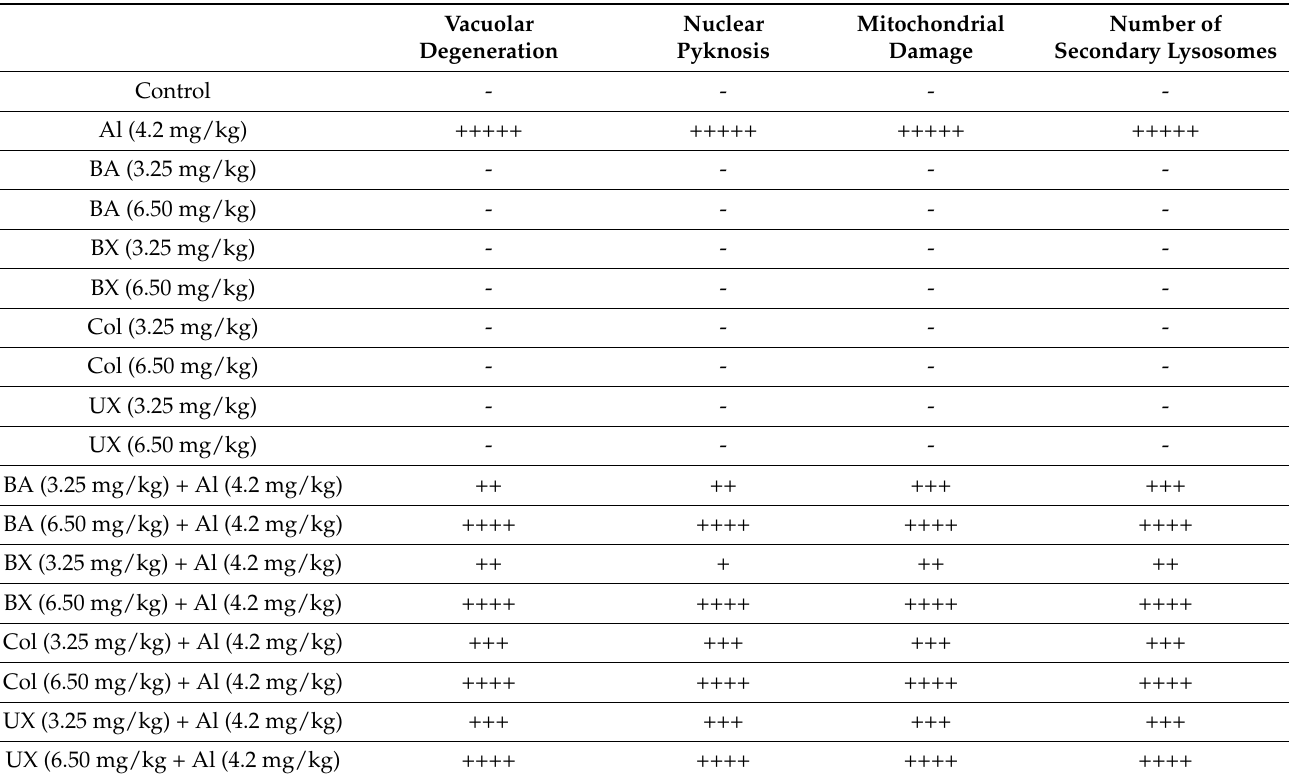
Table 7. Electron microscopic findings in cortex and hippocampus regions of rat brains after treatment with boron compounds and Al. (- nonsignificant; + significant at %0.01; ++ significant at